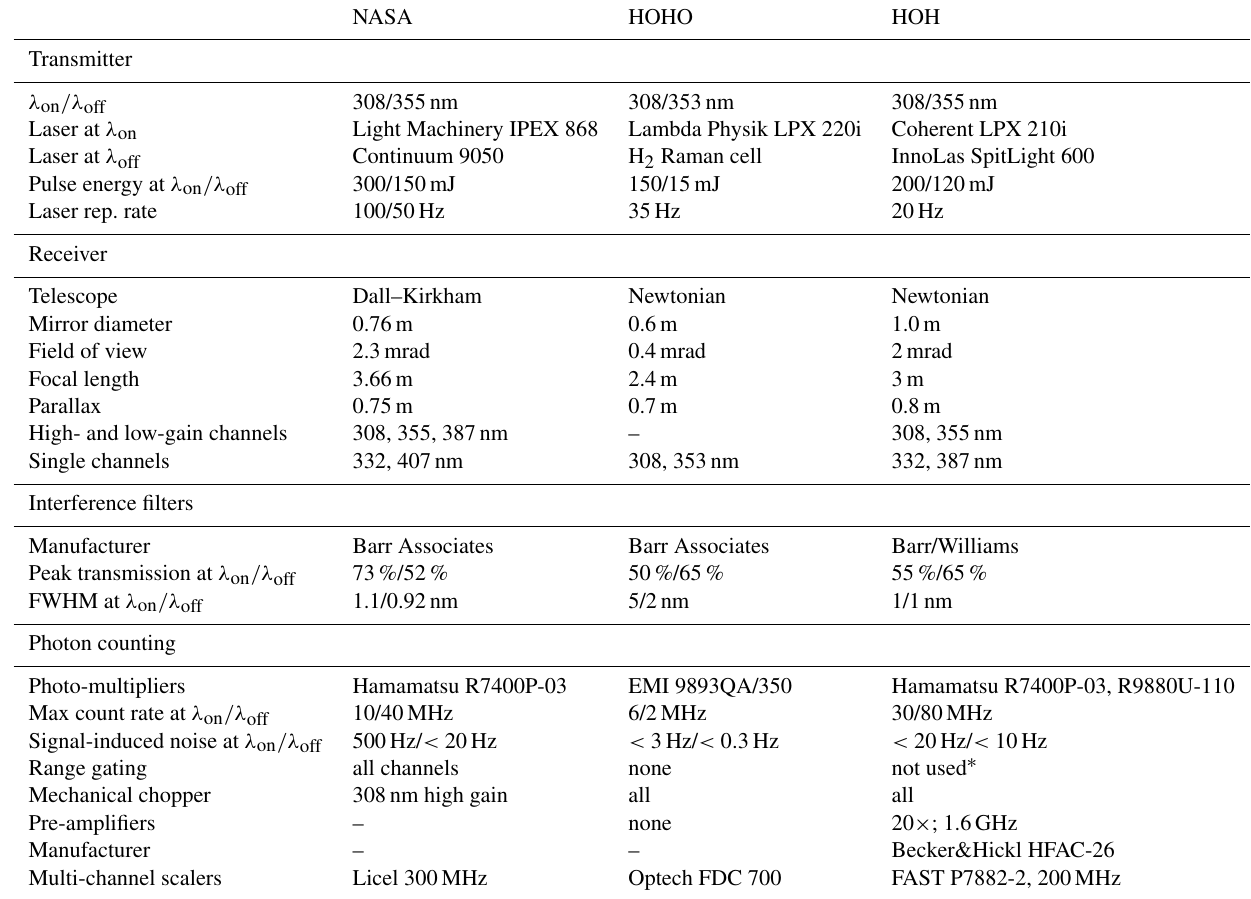
Table 4. Technical specifications for the lidars participating in the HOPS campaign. NASA